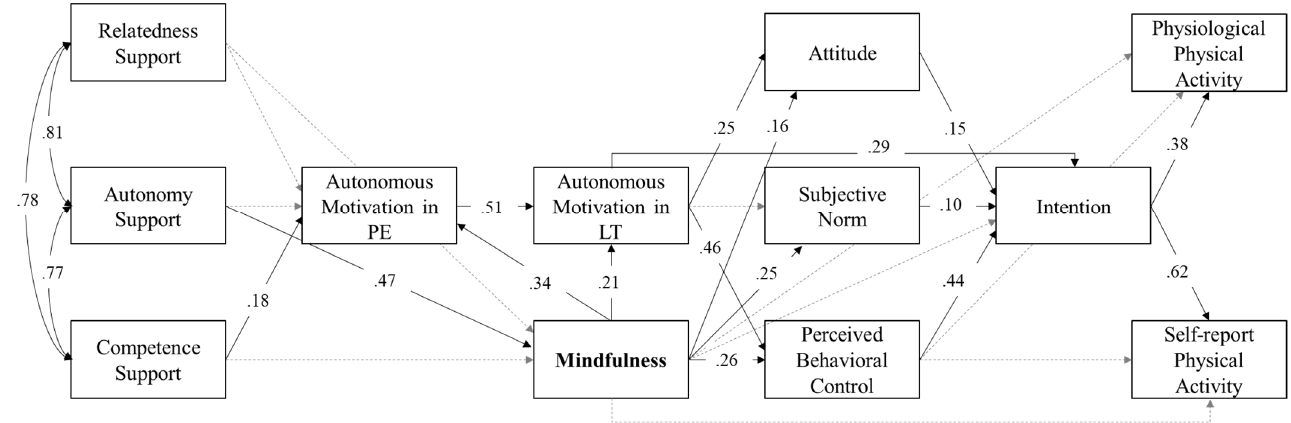
Figure 3. Path model (Model 2b) including mindfulness and physiologically measured physical activity. Model based on a sample size of n = 240 students. All calculated and standardized estimation paths are presented. Significant paths are depicted by solid arrows ( p < .05), while non-significant paths are represented by dashed arrows ( p > .05). PE = Physical education context; LT = Leisure time context.